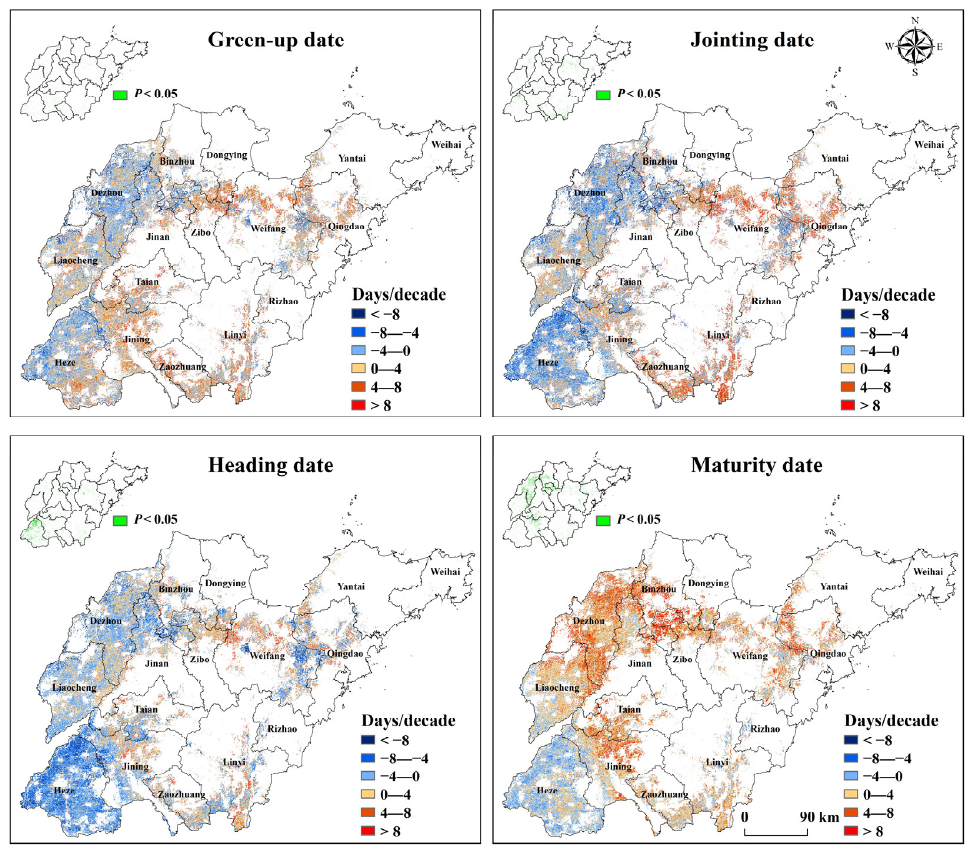
Figure 7. Change trends of winter wheat green-up date, jointing date, heading date, and maturity date in Shandong Province during 2003–2019. The inset at the upper left indicates the pixels with significant trends.